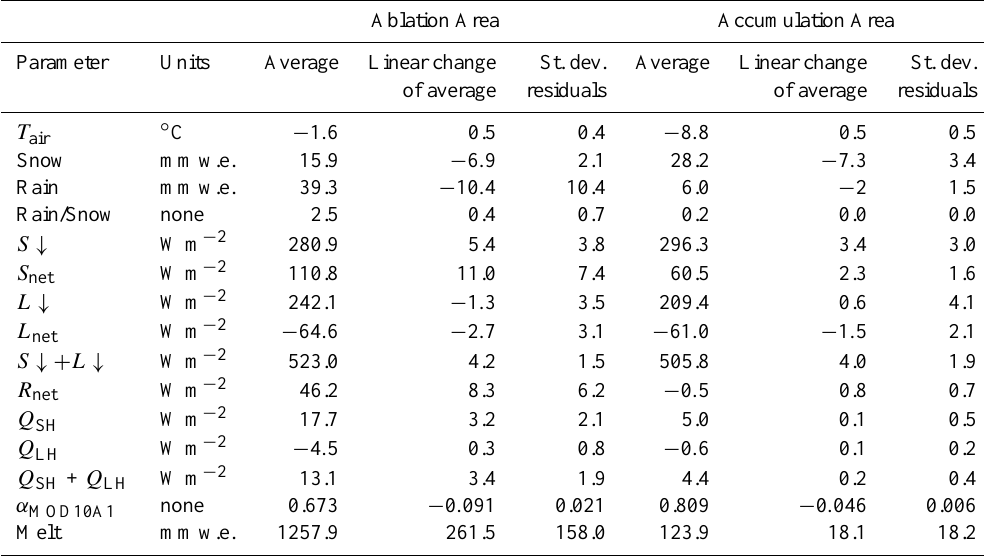
Table 2. Ice sheet summer (June–August) surface climate variability 2000–2011 from the MAR regional climate model and MODIS MOD10A1 data partitioned among ablation and accumulation areas by annual surface mass balance.